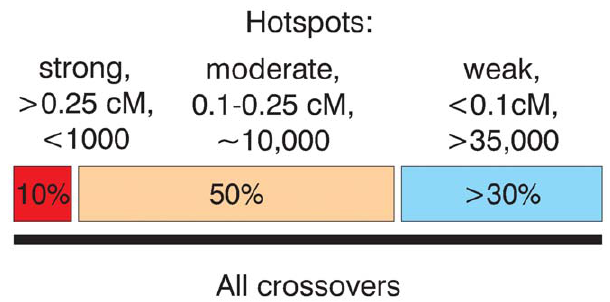
Figure 6. Schematic representation of the relative input of strong and weak hotspots to the total set of crossovers.